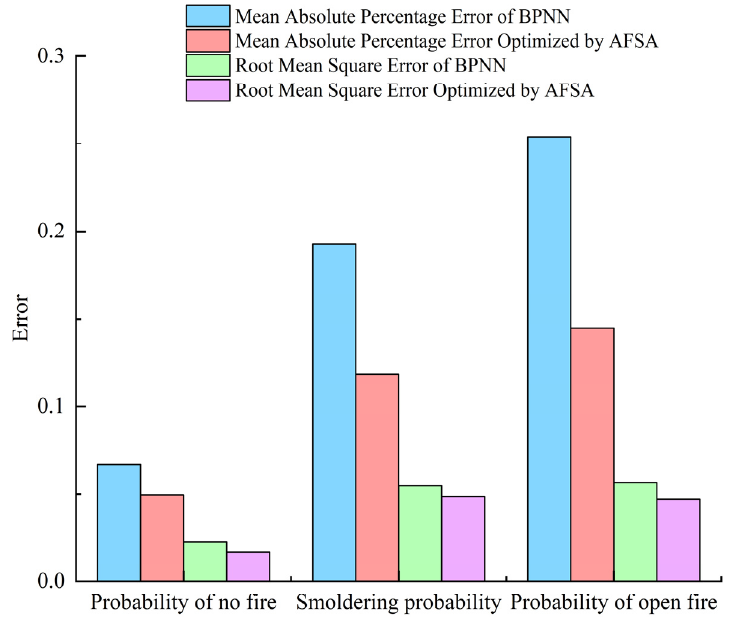
Figure 6. Error of BPNN and AFSA-BPNN algorithms in predicting fire probability. Table 1. Decision-making judgment of fire probability value of forecast samples.